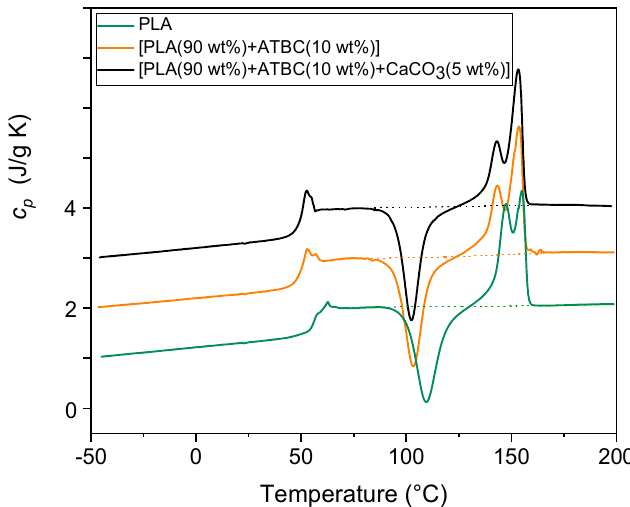
Figure 3. Specific heat capacity ( c p ) of PLA and PLA mixed with (1) ATBC and (2) ATBC and the mineral filler CaCO 3 at the concentrations indicated. The curves were obtained upon heating at 10 K/min after previous fast cooling to − 50 ◦ C. The dotted lines are the baselines used for the calculation of the ∆ h c and ∆ h m values. The ordinate values refer only to the bottom curve. All the other curves are shifted vertically for the sake of clearness. Table 2. Glass transition temperatures ( T g ), enthalpy of cold crystallization ( ∆ h c ), enthalpy of fusion ( ∆ h m ), and crystalline weight fraction growing during cold crystallization ( w Cc ) and disappearing during fusion ( w Cm ) for PLA and PLA mixed with (1) ATBC and (2) ATBC and the mineral filler CaCO 3 (estimated errors: ± 0.5 ◦ C for T g ; ± 1 J/g for ∆ h c and ∆ h m , and ± 0.02 for w Cc and w Cm